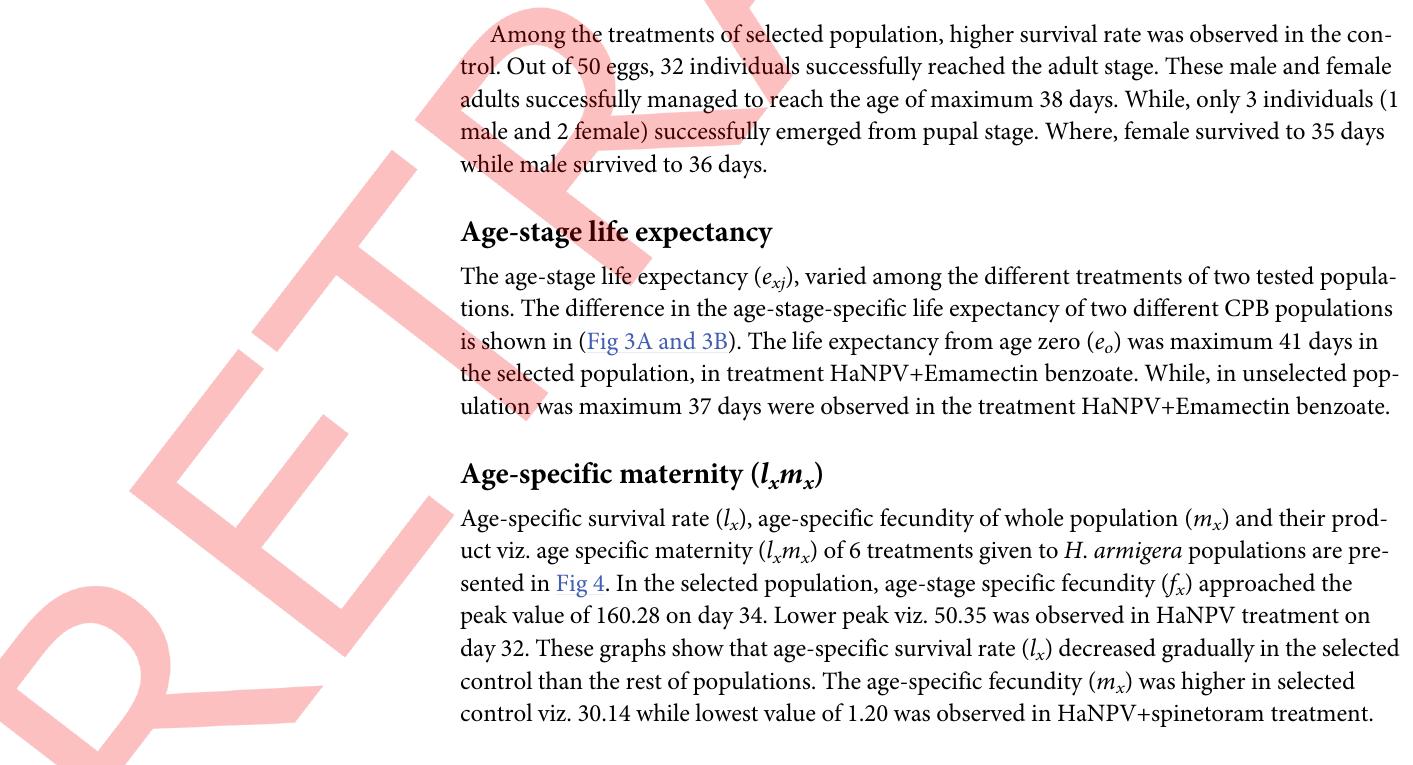
) on emamectin benzoate selected population of Helicoverpa armigera . xj